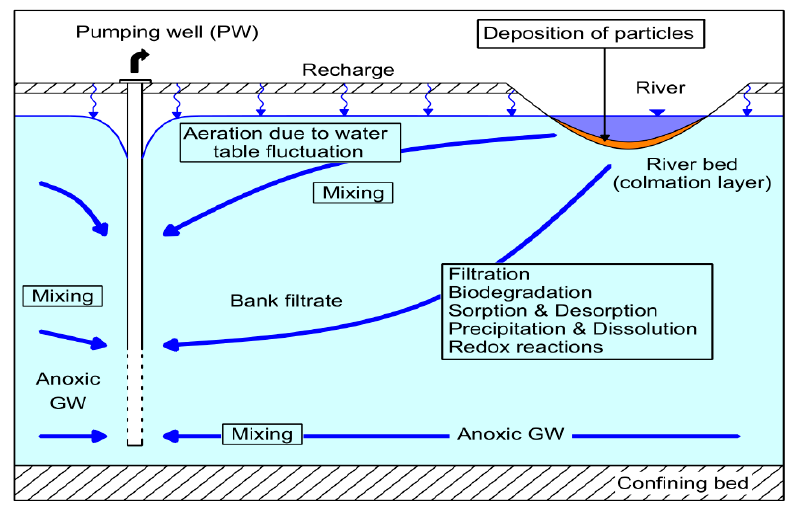
Figure 1. A schematic diagram of processes affecting water quality during riverbank filtration and groundwater (GW) [4].